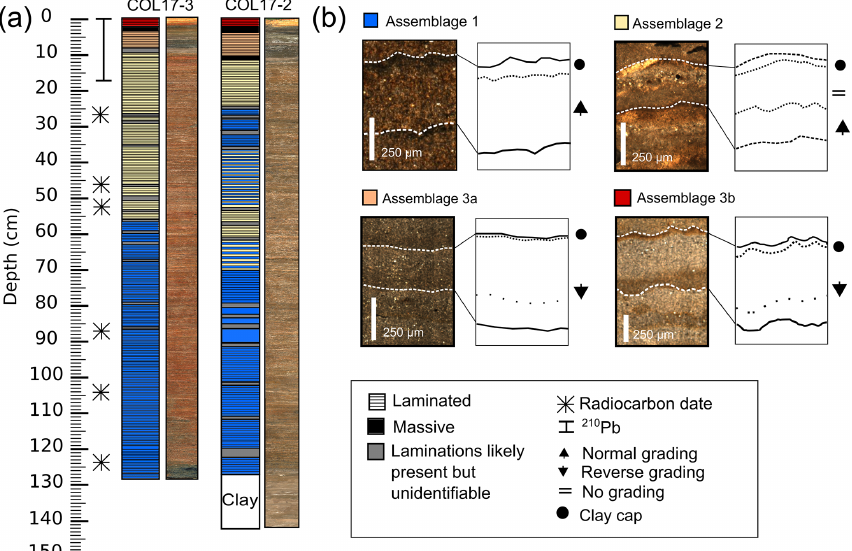
Figure 4. Sediment and lamination profiles. (a) Lithostratigraphy and location of radiometric samples of cores COL17-3 and COL17-2. Images are true color. The base of COL17-3 is black because the oxidized red crust has been scraped off. (b) Microscopic thin section examples of assemblages 1, 2, and